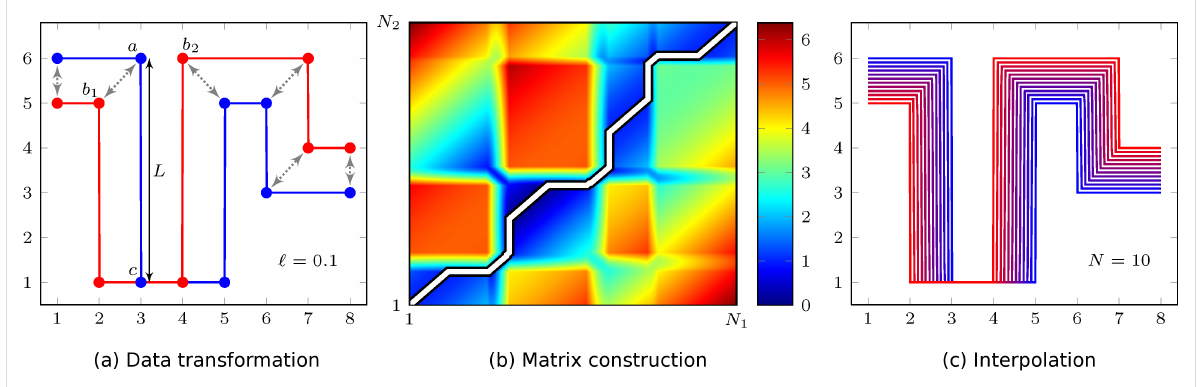
Figure 2: We seek an interpolation of the two datasets (red, blue) containing N 1 and N 2 points, respectively. The three steps in the algorithm: (a) The original data sets are transformed into line segments of a maximum length = 0.1. Thus, for example the line segment a – c is split into 50 points. (b) The weighted Euclidean distance is calculated for all point on both curves, and the shortest path from (1, 1) to ( N 1 , N 2 ) is found. (c) The curves are linearly interpolated using the found path with N = 10 intermediate